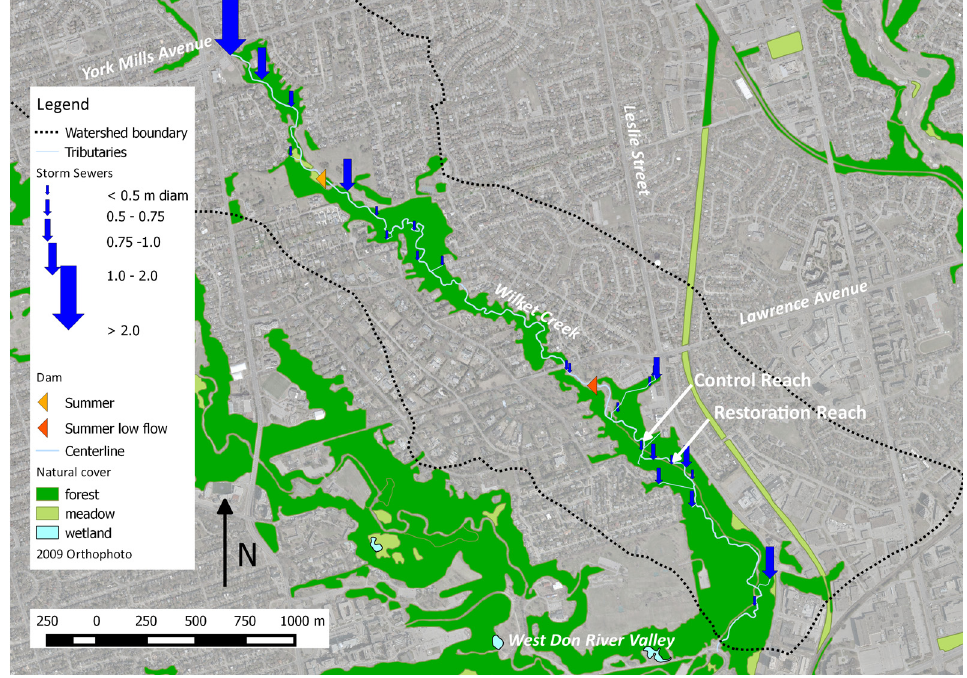
Figure 2. Open channel section of Wilket Creek including locations of control and restoration study reaches. The natural cover GIS layer was provided by the Toronto Region Conservation